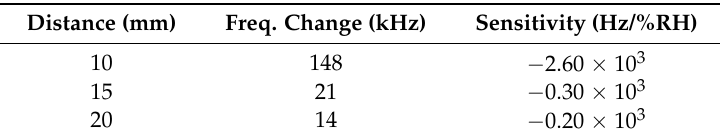
Table 1. Resonance frequency of the reader while coupling the wireless sensor at the minimum (20%) and maximum (80%) RH level tested for different distances.